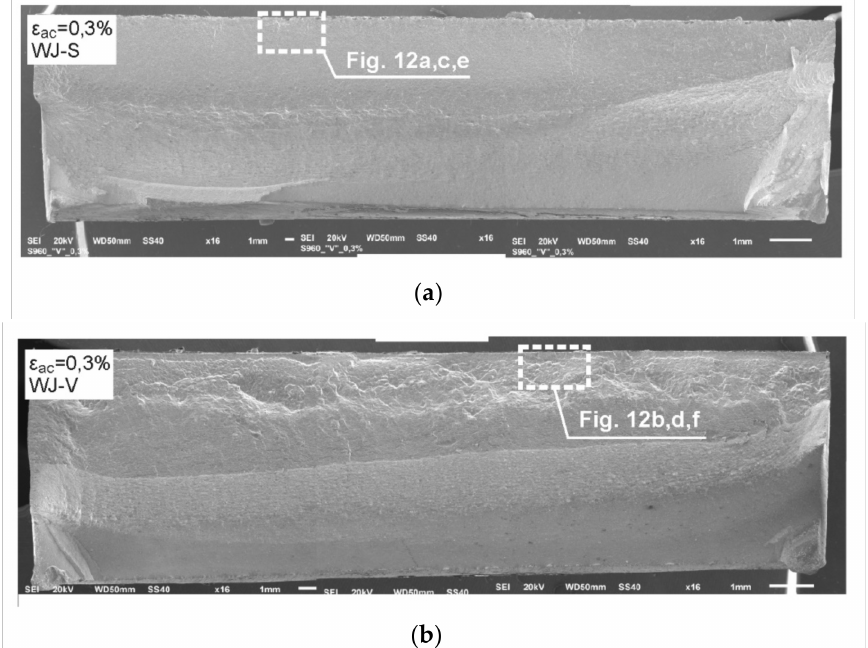
Figure 11. The panoramic photographs of fatigue fractures of the welded samples tested at ε ac = 0.3%: ( a ) WJ-S joint; ( b ) WJ-V